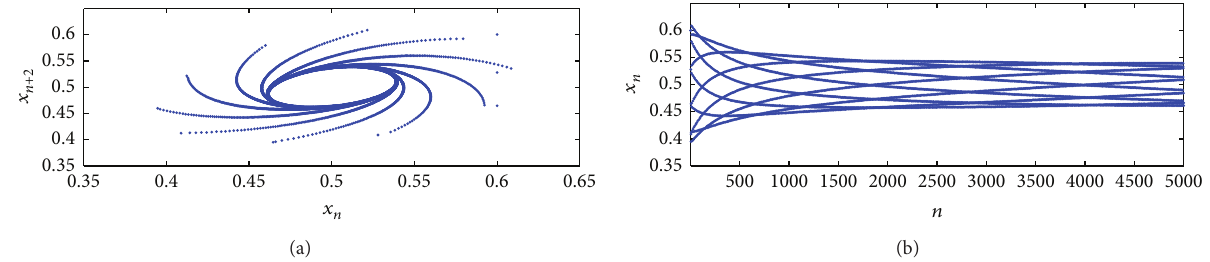
Figure 2: A stable invariant closed circle bifurcating from 𝑥 ∗ , where 𝑎 1 = 1.6 , 𝑎 2 = 0.8 , 𝑚 = 2 , and 𝑟 = 0.5156 > 𝑟 1 = 0.515 .